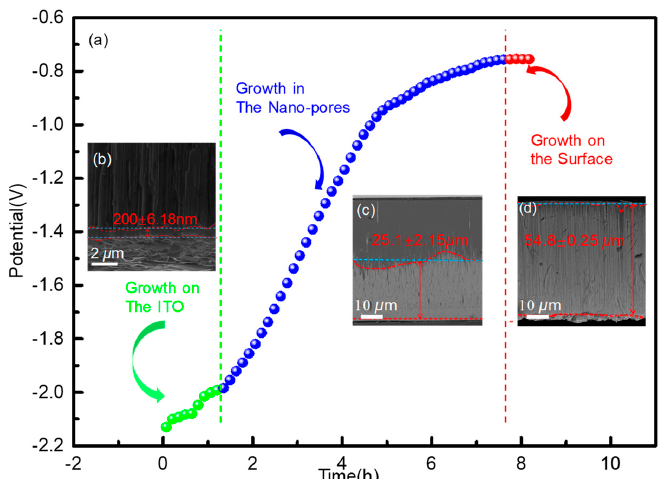
Figure 6. Potential vs. time curve for the galvanostatic electrodeposition of CNPs ( i = 5 A/dm 2 ) into pores of an AAO film. The scheme displays three different stages of the growth process: in region ( a ) growth on the ITO glass; ( b ) growth in the nano-pores; in region ( c ), growth on the surface.